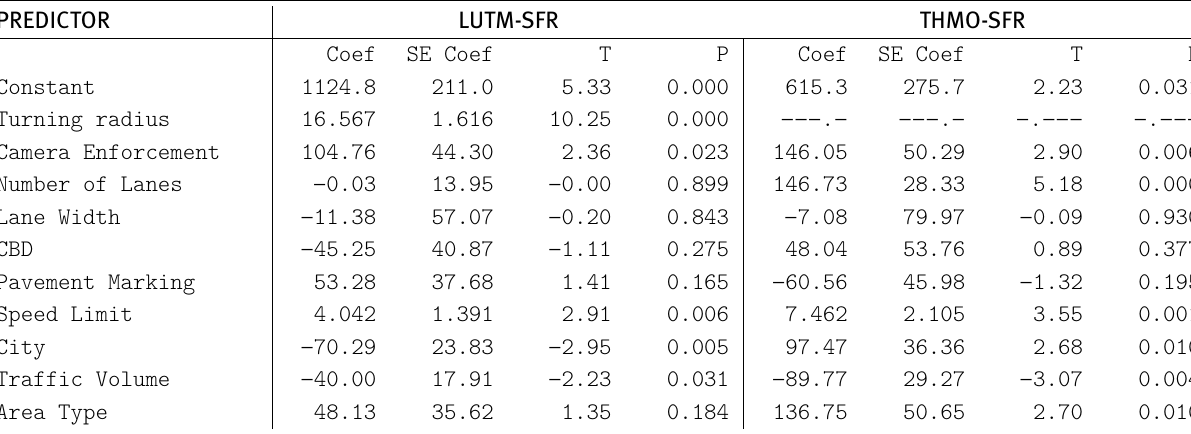
Table 3: Minitab Output Regression Analysis for All Variables